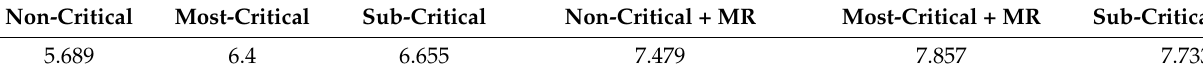
Table 5. Total fixation time in Road area ahead (s).